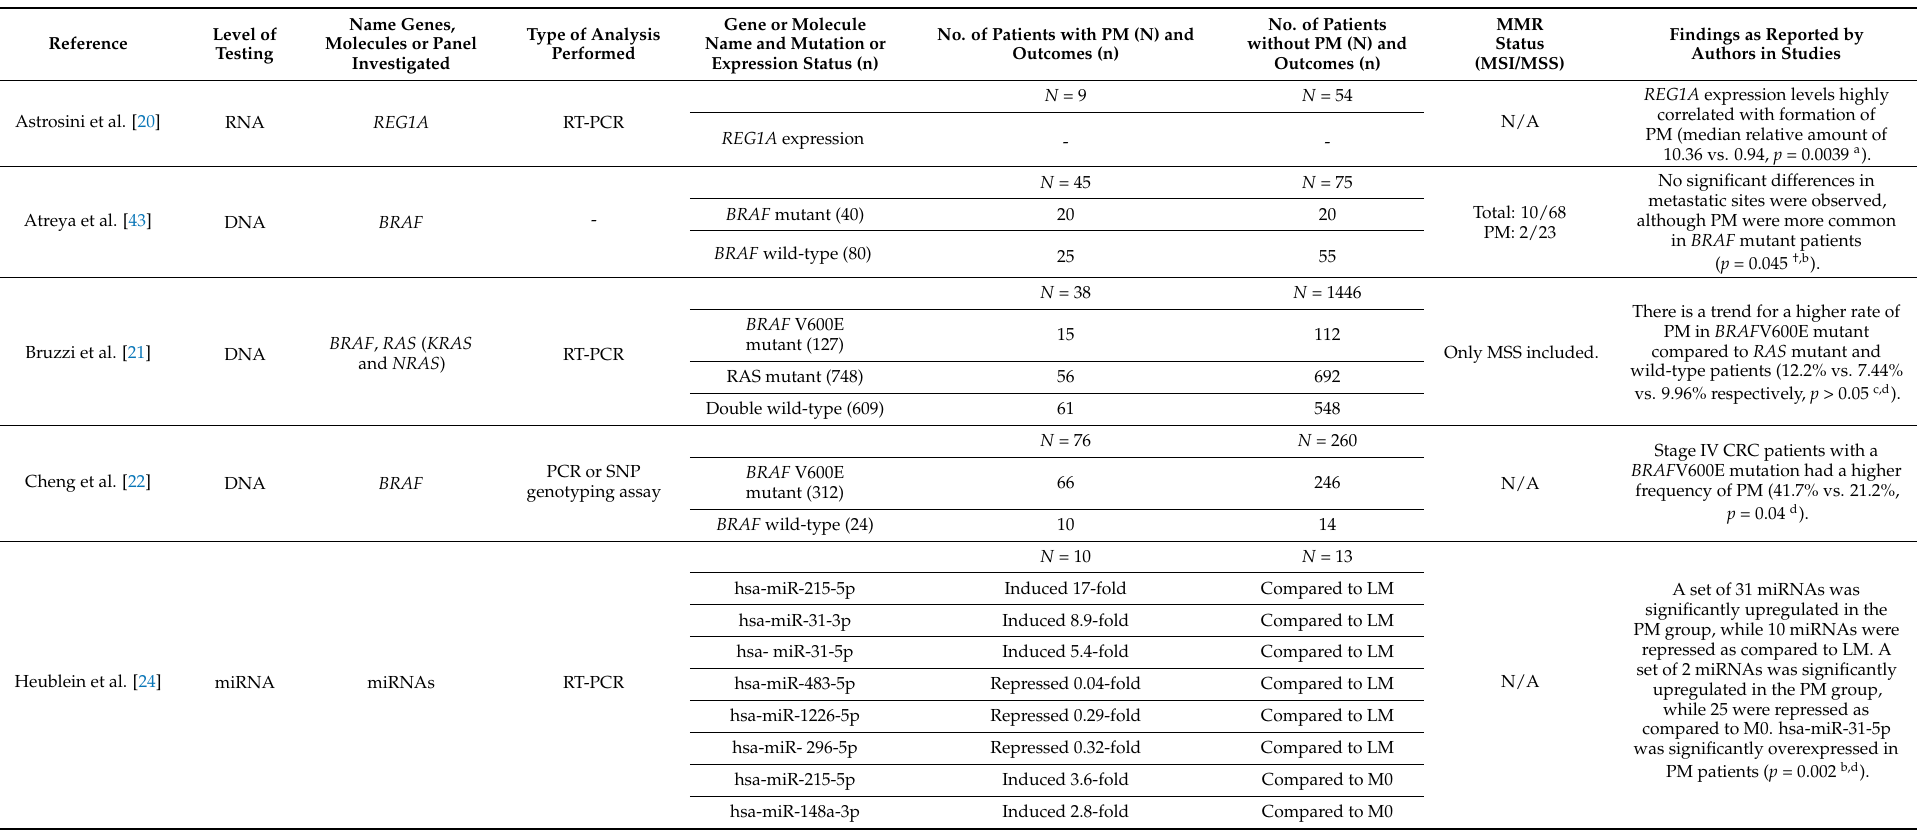
Table 3. Overview of genetic analysis and